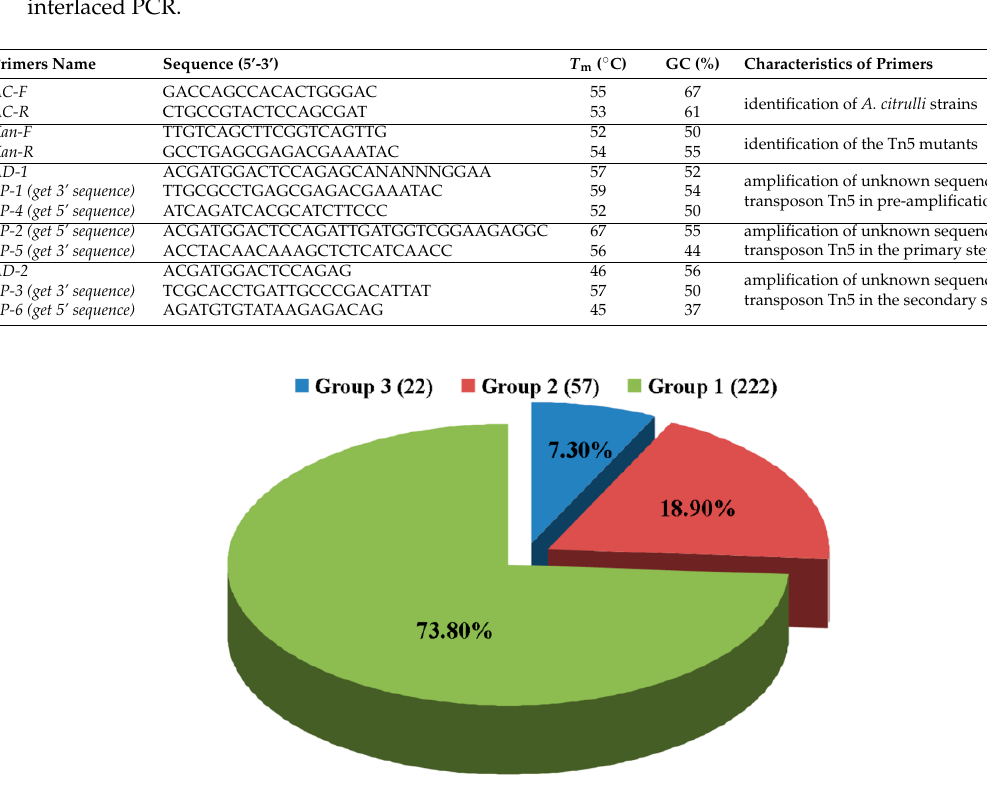
Table 1. Oligonucleotide primers used in this study for high-efficiency thermal asymmetric interlaced PCR.